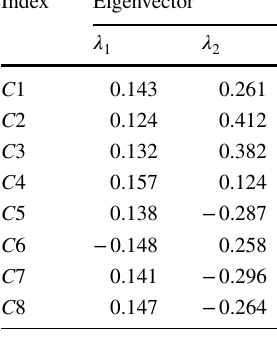
contribution rate of